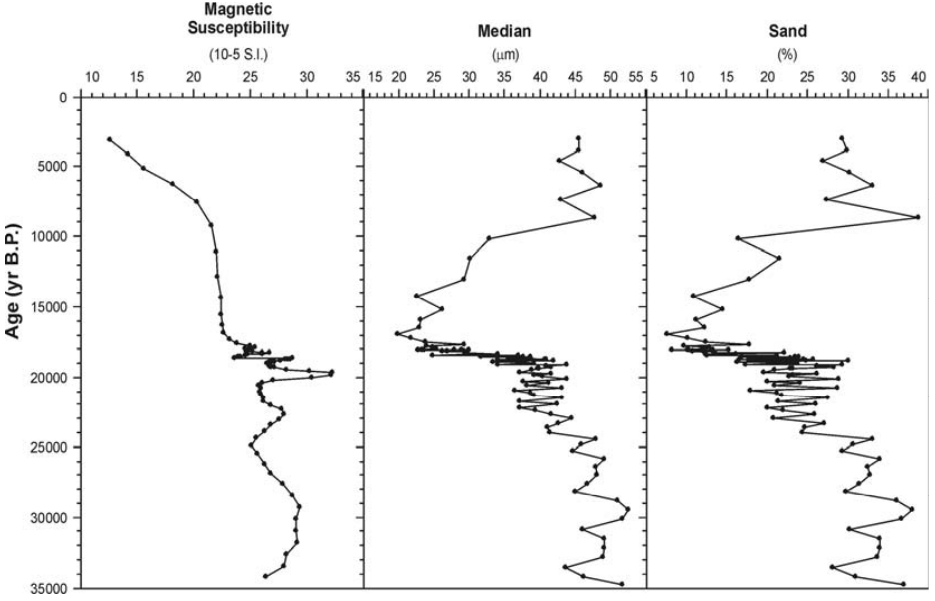
Fig. 3 – Variations in magnetic susceptibility and grain-size in core 7485. Isotope stage limits based on Martinson et al.